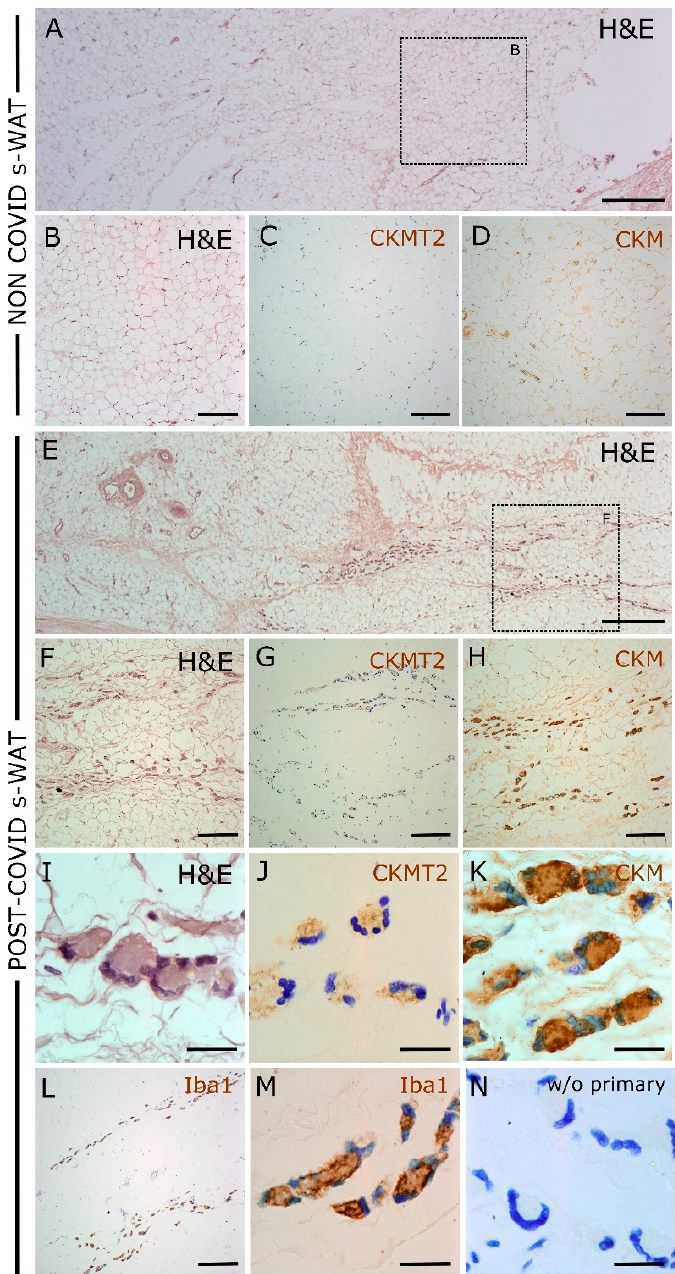
Figure 4. Immunohistochemical analysis of post-COVID and non-COVID patients’ s-WAT samples. ( A ) Low-magnification image of H&E staining, representative of non-COVID patients, showing normal-appearing adipose tissue. ( B – D ), higher-magnification details in which low or absent im- munoreactivity of CKM ( C ) and CKMT2 ( D ) is observed. ( E ) Low-magnification image of H&E staining, representative of post-COVID patients, showing tissue distortion and accumulation of large macrophage-like cells (detail in ( F )). A remarkable increase in CKM ( G ) and CKMT2 ( H ) im- munoreactivity can be observed in post-COVID patients, as it is highly concentrated in these cells. ( I – K ) High-magnification images showing that CKM and CKMT2 immunoreactive cells are morpho- logically similar to multinucleated giant cells (MGCs). Mild toluidine blue counterstaining allowed the visualization of cell nuclei. ( L , M ) Cells expressing CKM and CKMT2 also express the macrophage marker Iba1. ( N ) The absence of primary antibody shows no specific staining. H&E, hematoxylin and eosin staining. Magnification bars: ( A , E ) 500 µ m; ( B – D , F – H , L ) 100 µ m; ( I – K , M , N ) 25 µ